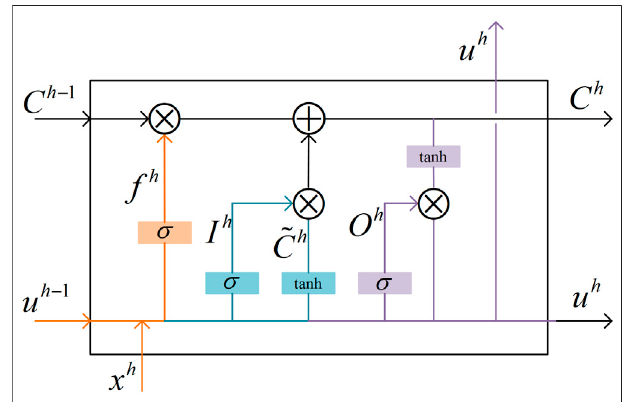
FIGURE4| StructureofthehiddenlayerintheLSTMmodel,wherethree gates (forget gate, input gate, and output gate) ensure the time-series forecasting